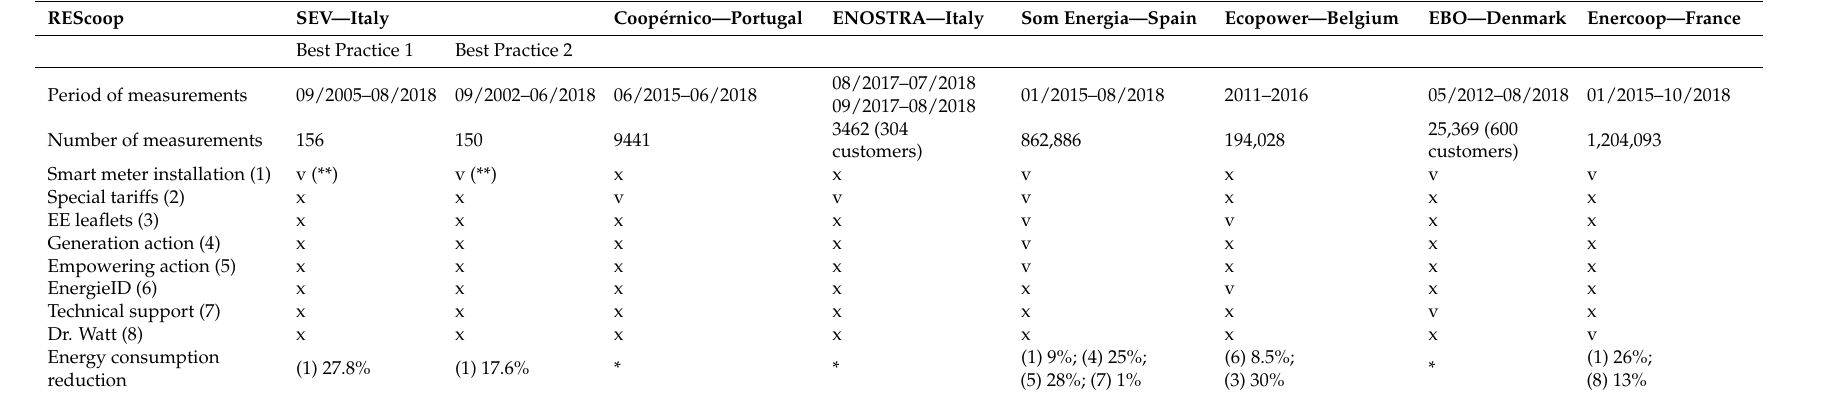
Table 10. The effectiveness of the proposed